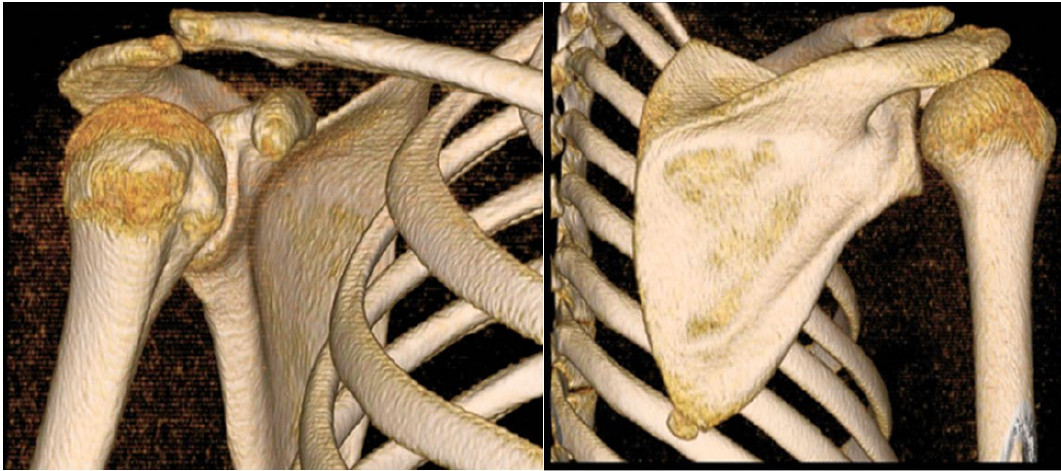
Figure 2. Preoperative 3D (vision) reconstruction CT scan, with posterior and upper clavicle subluxation.